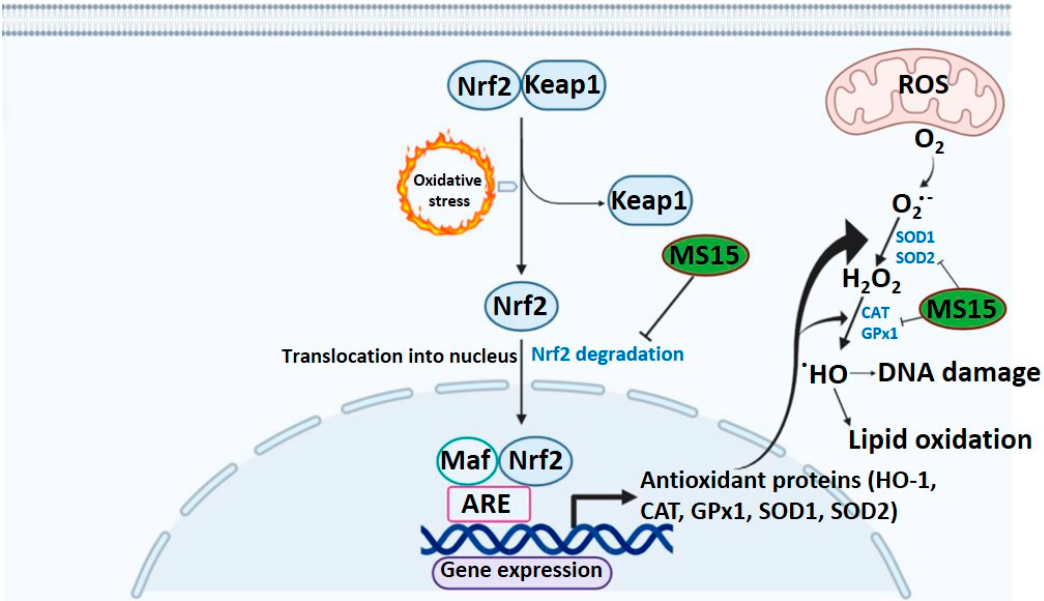
Figure 7. Illustration of hypothetical antioxidant mechanism for peptide MS15 against oxidative stress.